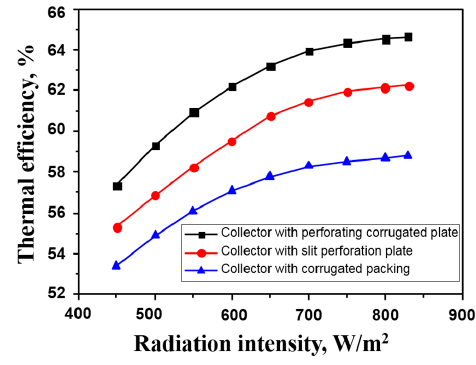
Figure 6. Comparison of collectors at different radiation intensities.